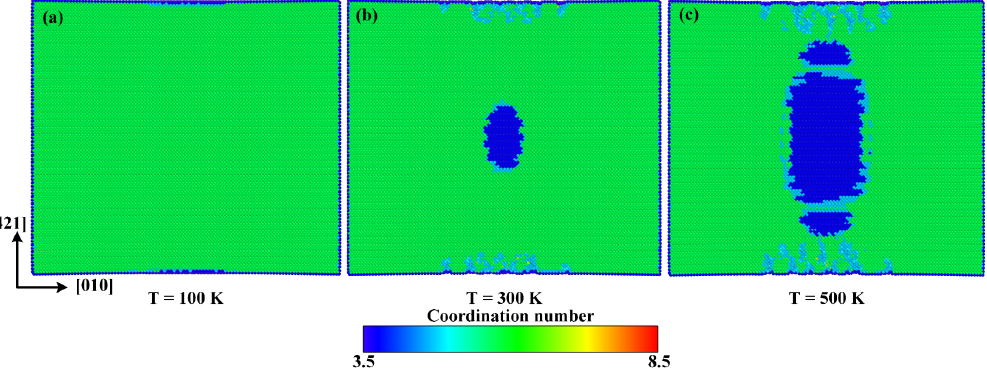
Figure 12. Atomic configurations when the strain reaches 0.125 at ( a ) 100 K, ( b ) 300 K, and ( c ) 500 K, respectively.